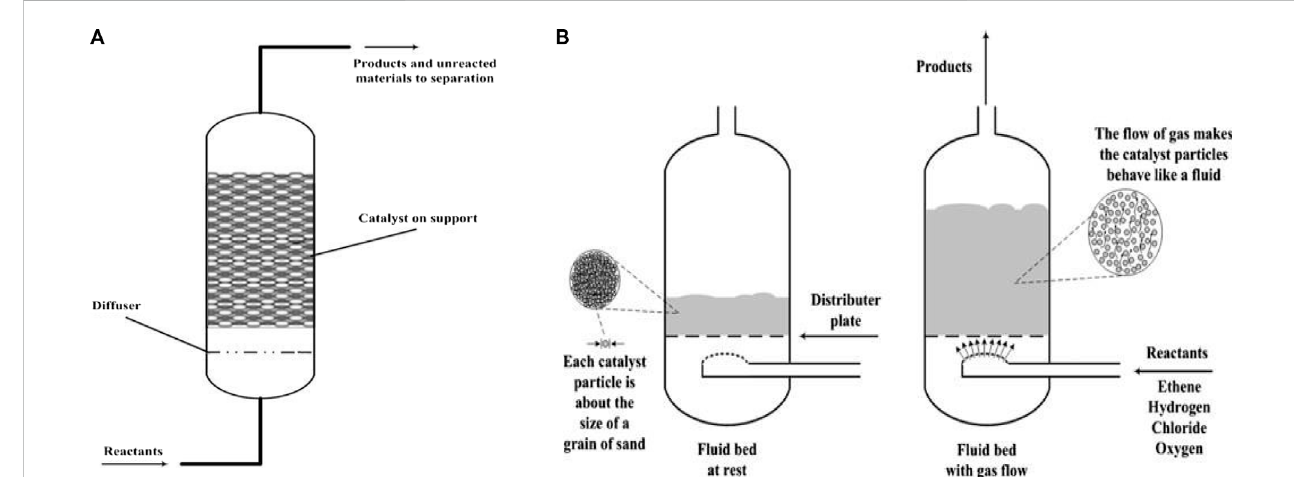
FIGURE 11 Representations of (A) fi xed-bed (packed) reactor and (B) fl uidized bed reactor (FBR) (The University of York, 2013).